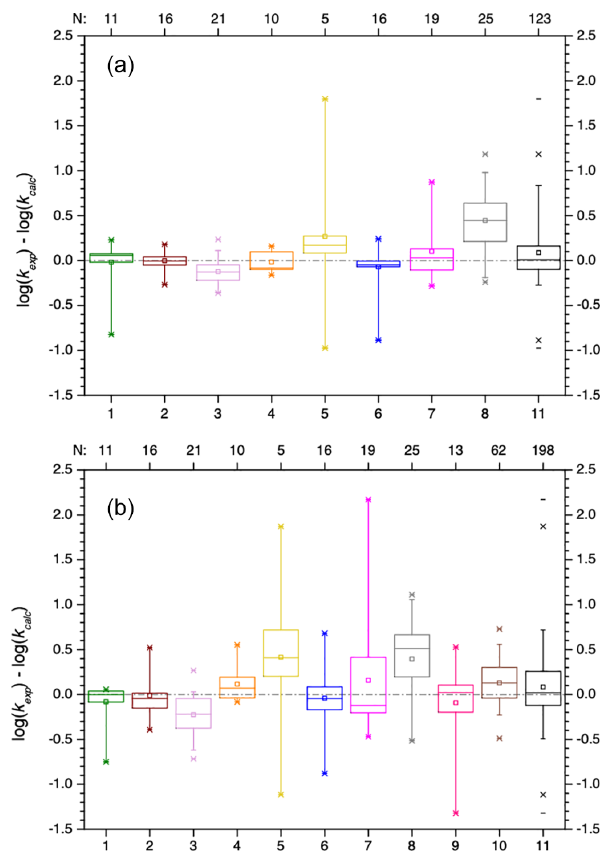
Figure 9. Box plots of the absolute errors of the logarithmized ex- perimental versus predicted rate constants for the prediction with the SAR of Doussin and Monod (2013) (top) and Minakata et al. (2009) (bottom). Numbers at the abscissa refer to the com- pound class: 1 – alkanes, 2 – mono-alcohols, 3 – di- and polyols, 4 – carbonyls, 5 – dicarbonyls, 6 – mono-carboxylic acids, 7 – di- carboxylic acids, 8 – polyfunctionals, 9 – unsaturated compounds, 10 – aromatics, and 11 – all data.